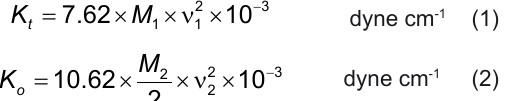
Table 3. Band position ( n Comp. x